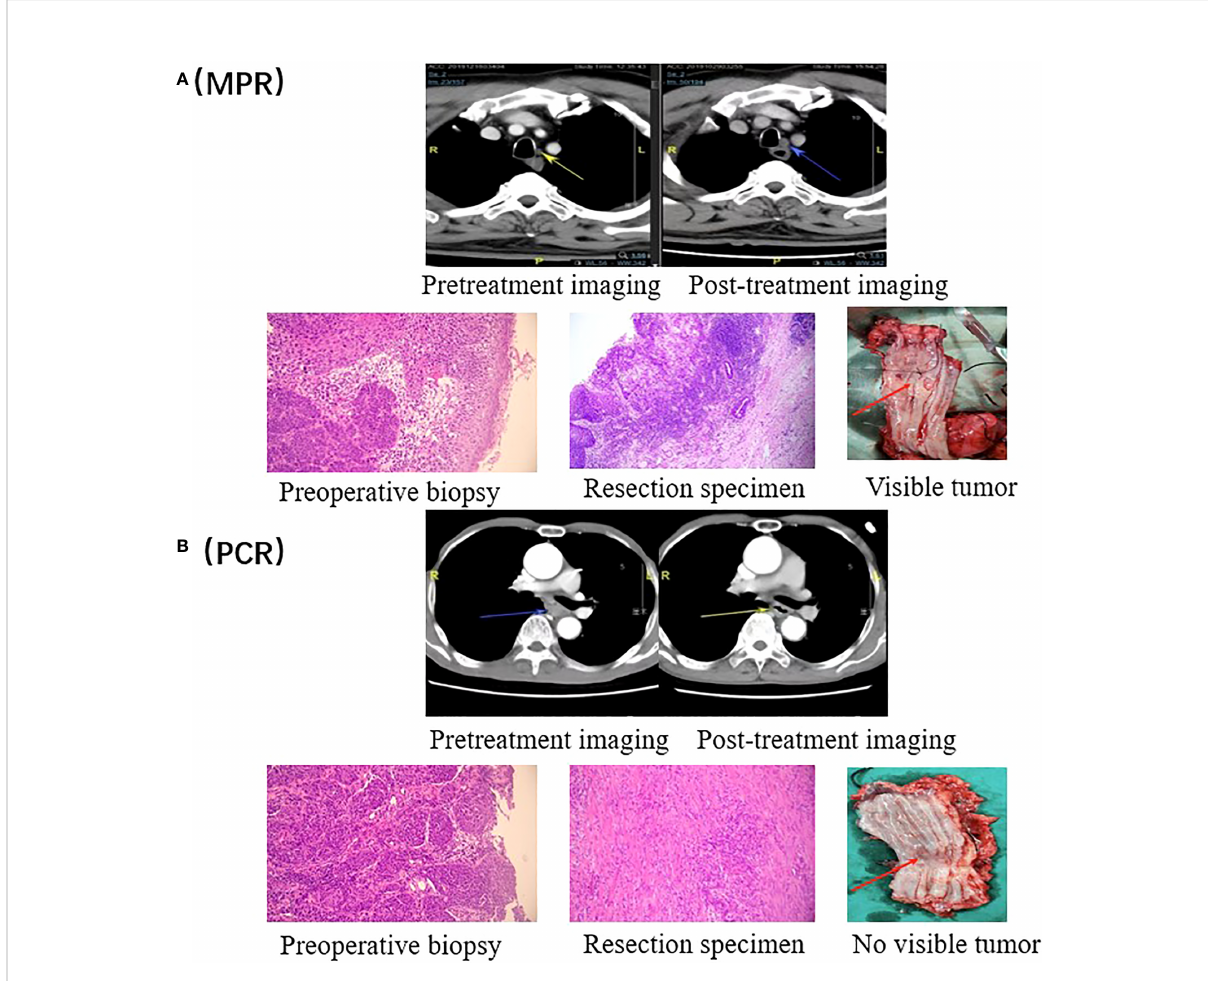
FIGURE 2 Radiographic and pathological responses. (A) Pretreatment and post- treatment CT and H&E images of a representative patient with a pathological response of MPR. The tumor is visible in the resected esophagus. (B) Pretreatment and post- treatment CT and H&E images of a representative patient with a PCR. There is no tumor visible in the resected